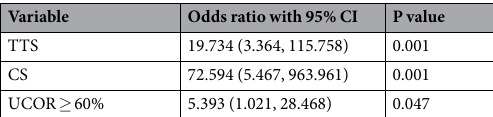
Table 2. Odds ratio of TTS, CS and UCOR ≥